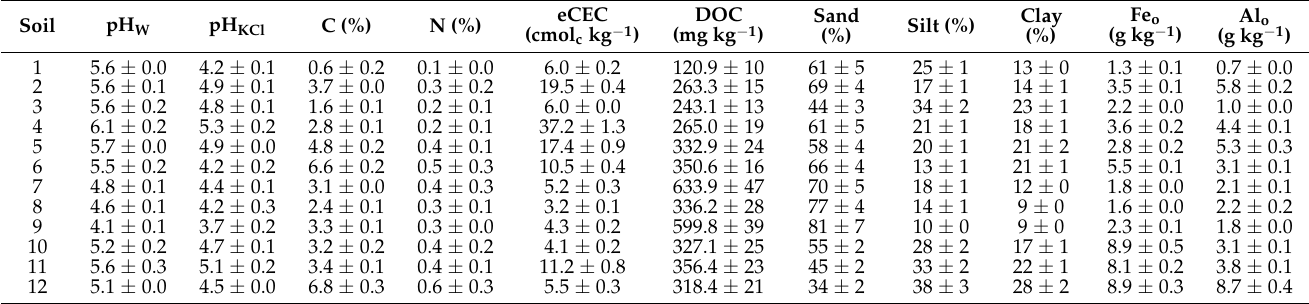
Table 1. General characteristics of studied soils mean value ± standard error (n =